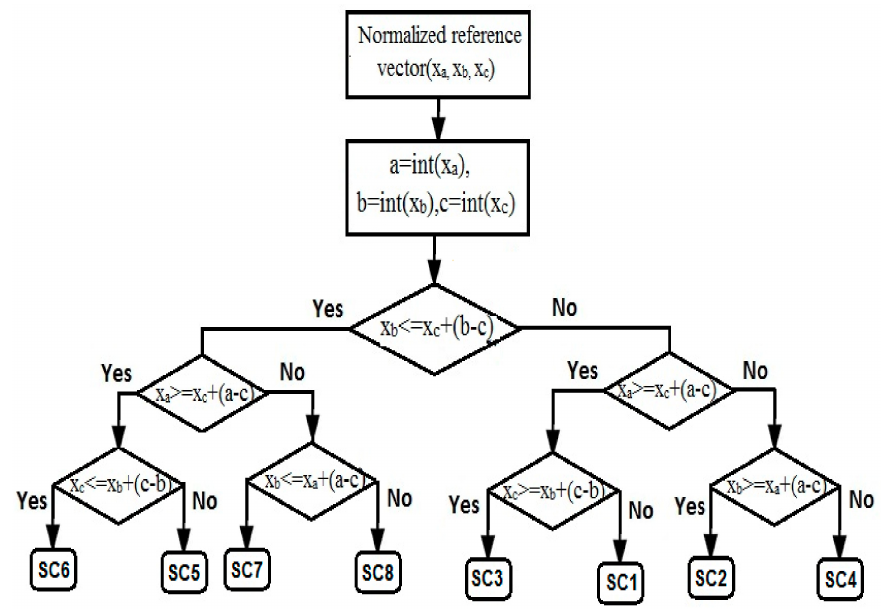
Figure 7. Flowchart for tracking of subcubes.